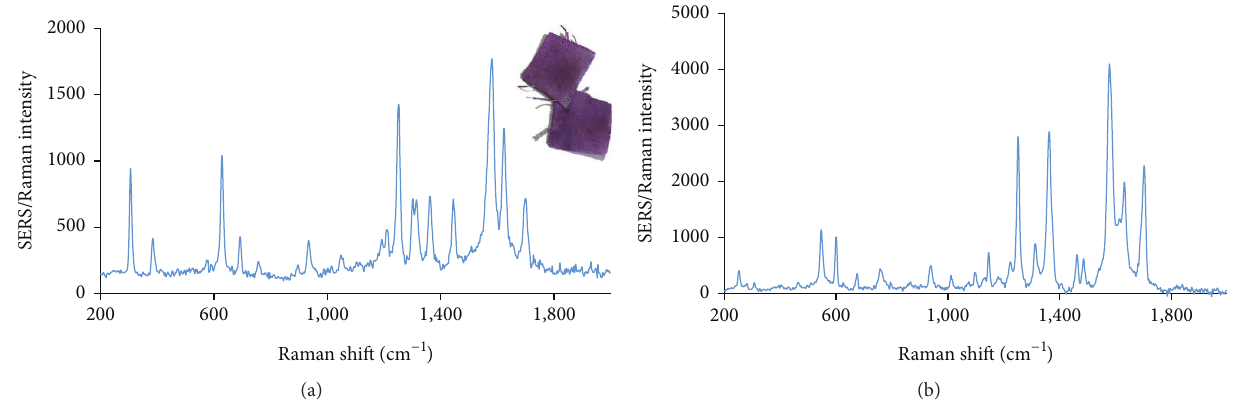
Figure 5: SERS spectrum (514nm excitation) of Tyrian purple extracted from a cotton fiber mockup by using an agar gel bead containing the leuco -reduction chemicals (a) and Raman spectrum indigo crystals